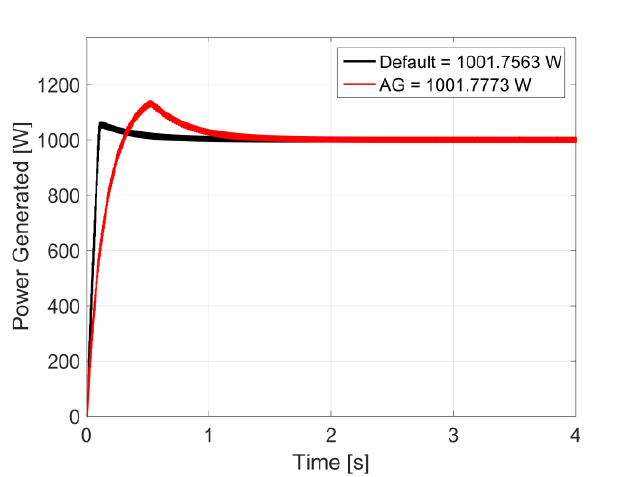
Fig. 9. SRG input mechanical power.